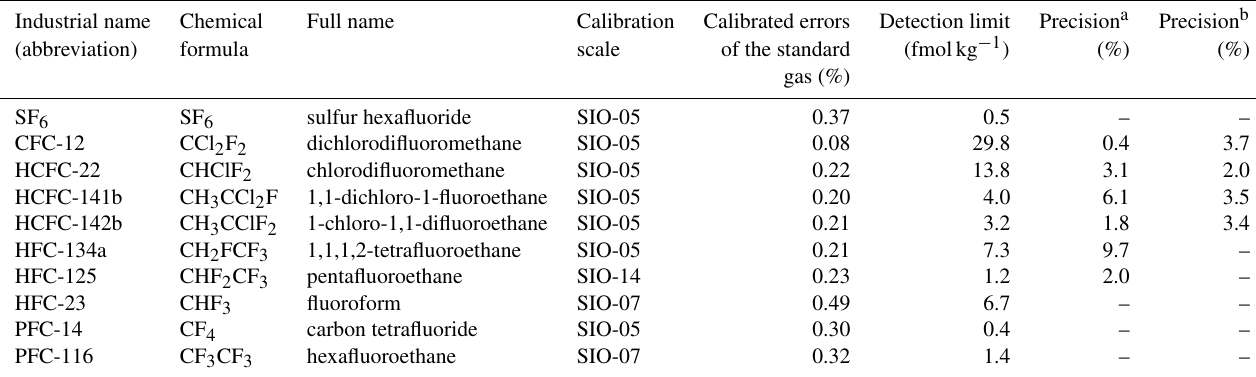
Table 1. Selected Medusa–Aqua analytes, calibration scales, and calibrated errors of the standard gas, detection limit, and seawater measure- ment